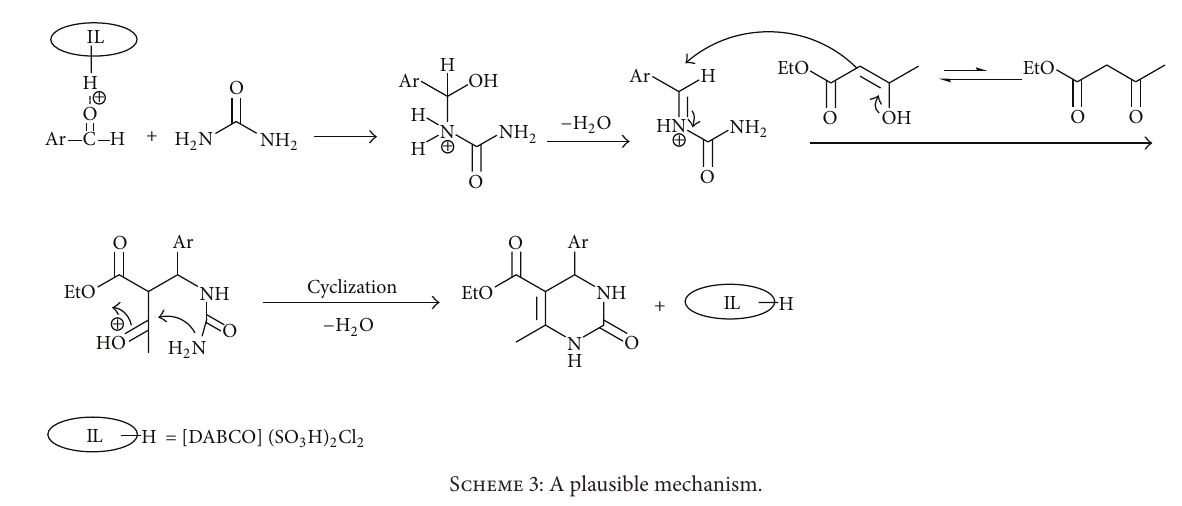
Table 1: [DABCO](SO